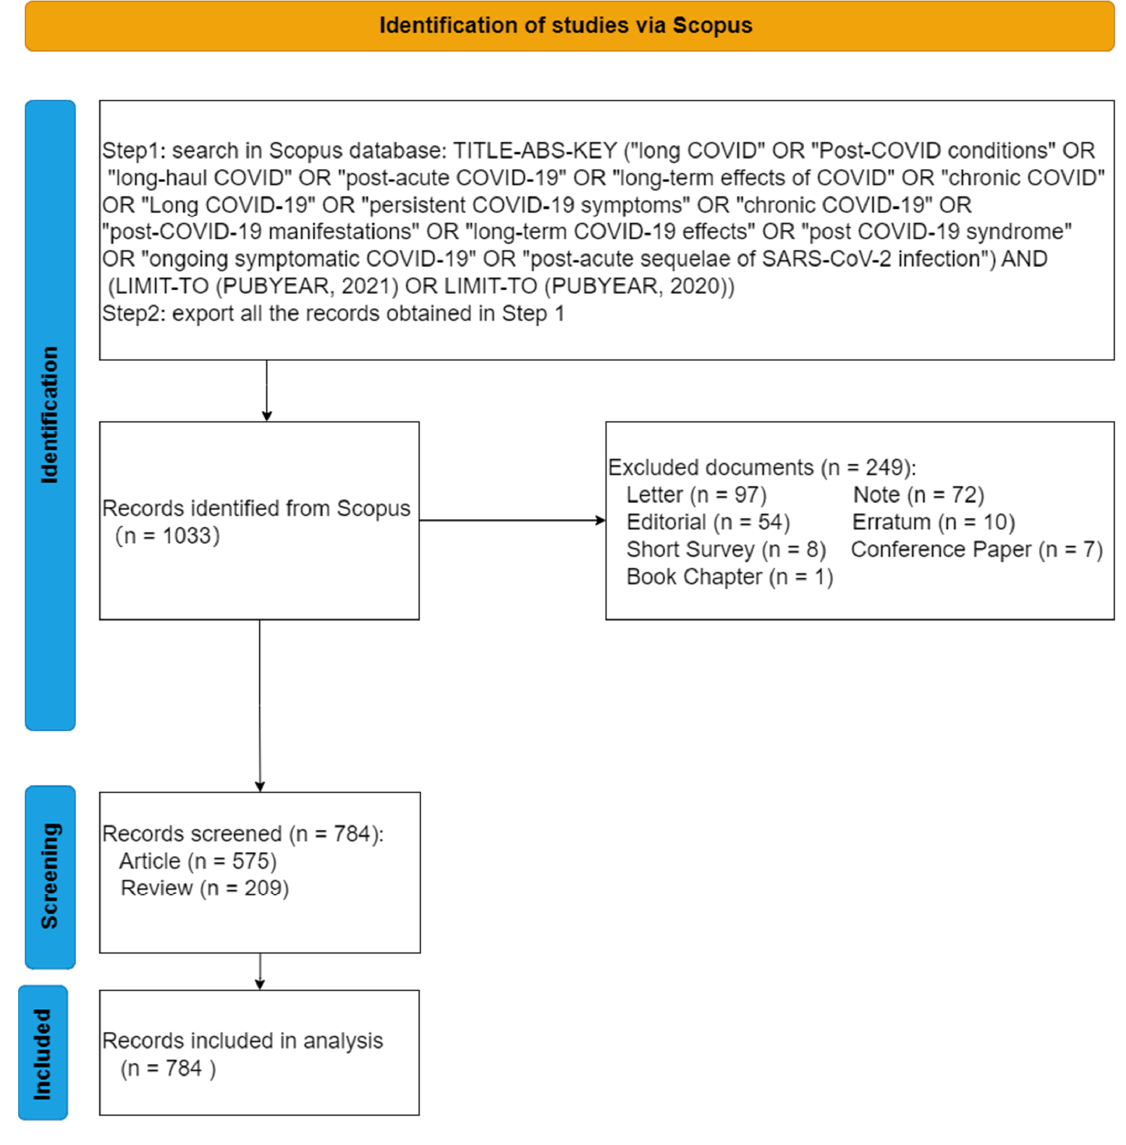
Figure 1. The flowchart of data selection.